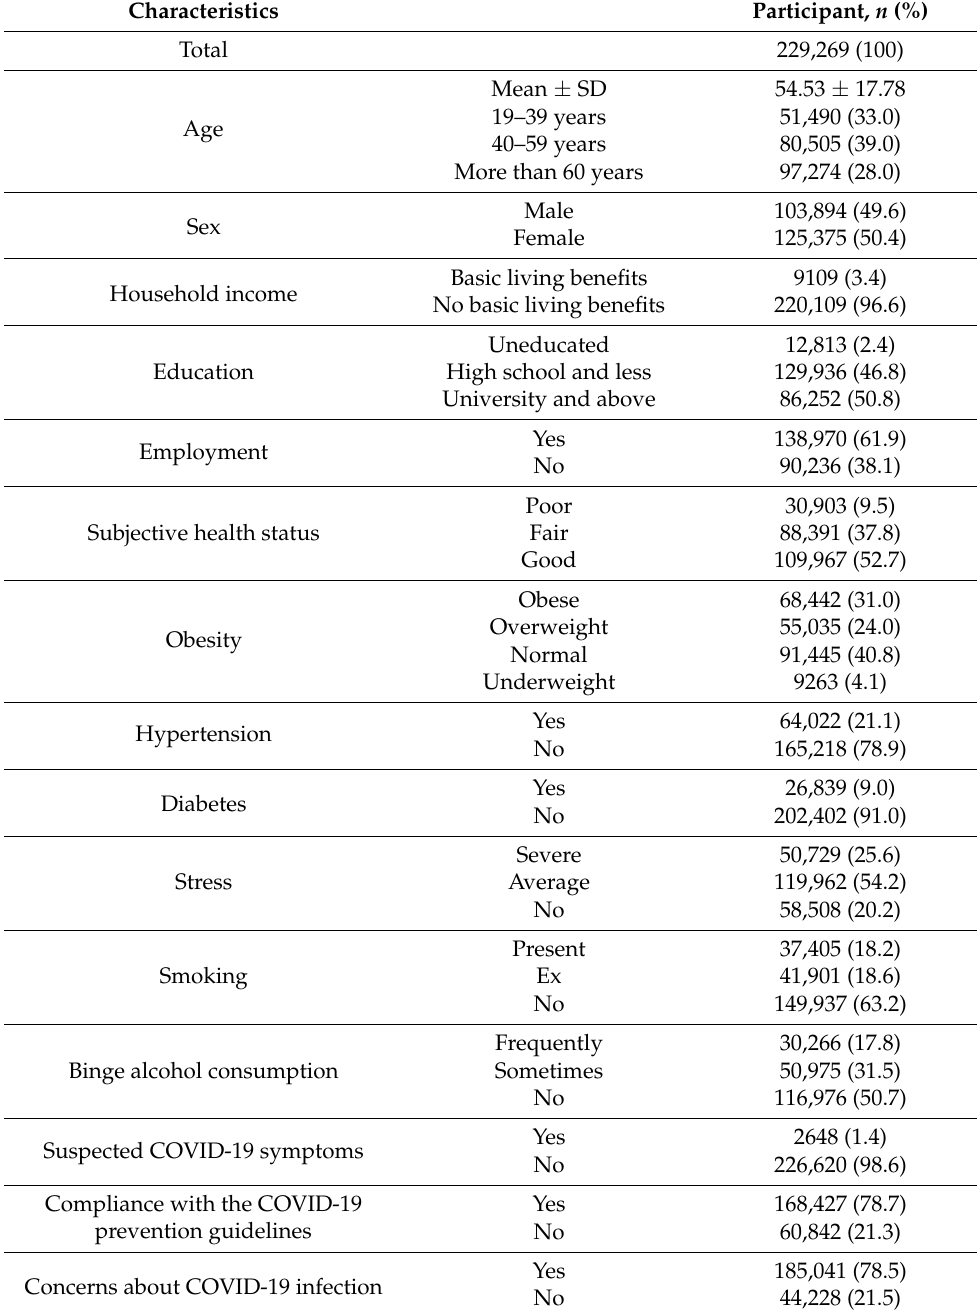
Table 1. Participant demographics, health status, health behaviors, and COVID-19 pandemic-specific